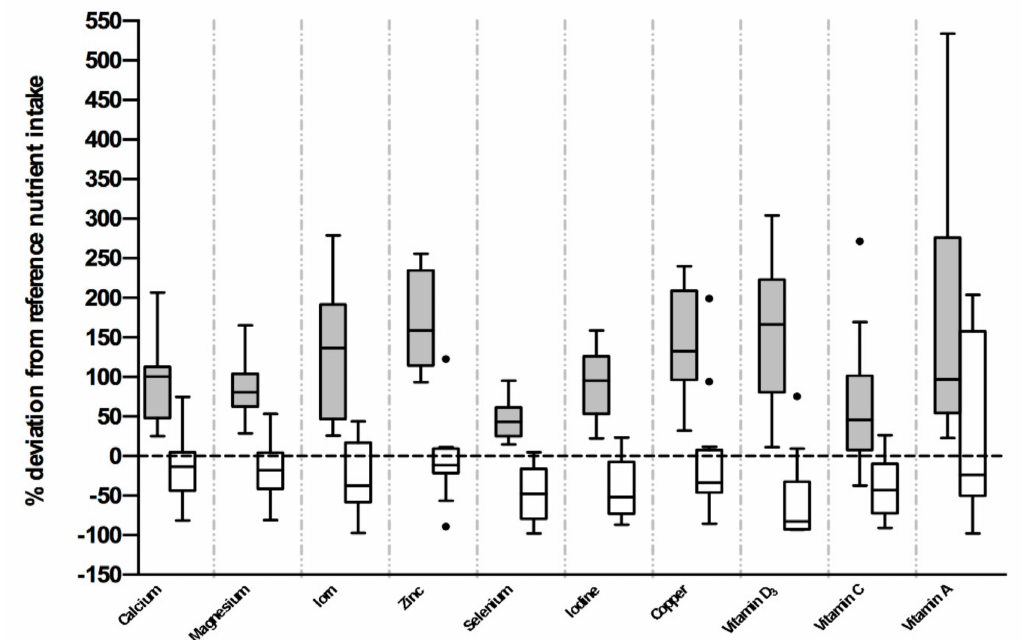
Figure 2. Nutrient intake is depicted as percent deviation from age and gender specific UK reference nutrient intakes. Tukey box and whisker plot. Grey shaded boxes [ ] represent the adherent patients, whereas white shaded boxes [ ] represent values obtained from the nonadherent